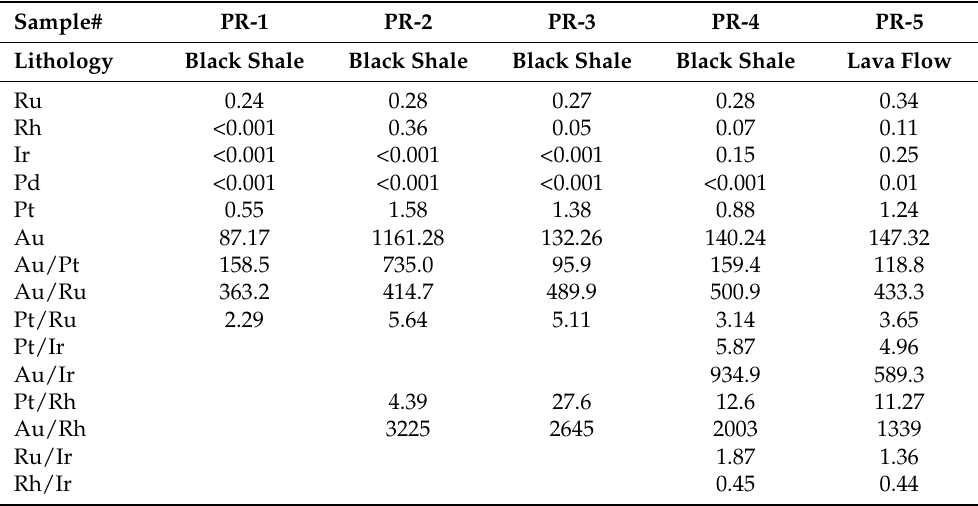
Rh/Ir Black shale samples show high to very high (up to 1161 ppb; Table 5) concentrations of gold and elevated platinum concentrations (0.55–1.58 ppb; Table 5), along with very low concentrations of palladium and most elements of the Ir-group (Ir, Rh, Ru). In fact, Pd is below the detection limit of 0.001 ppb in all black shale samples and Ir—in 3